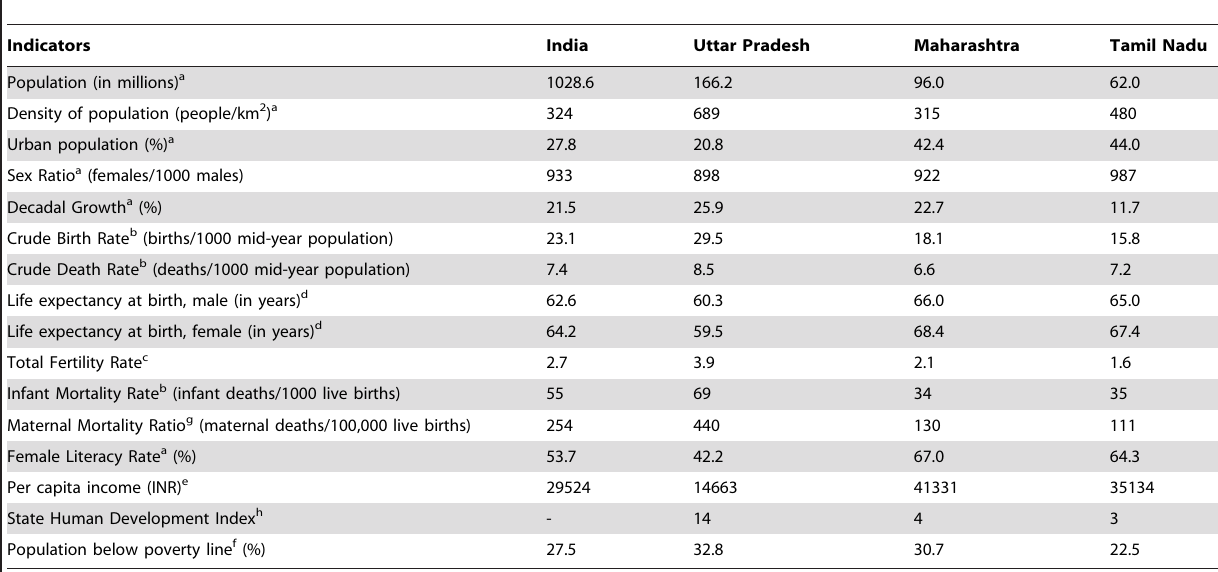
Table 1. Socioeconomic and demographic profile of the population of India and three selected states of Uttar Pradesh, Maharashtra, Tamil